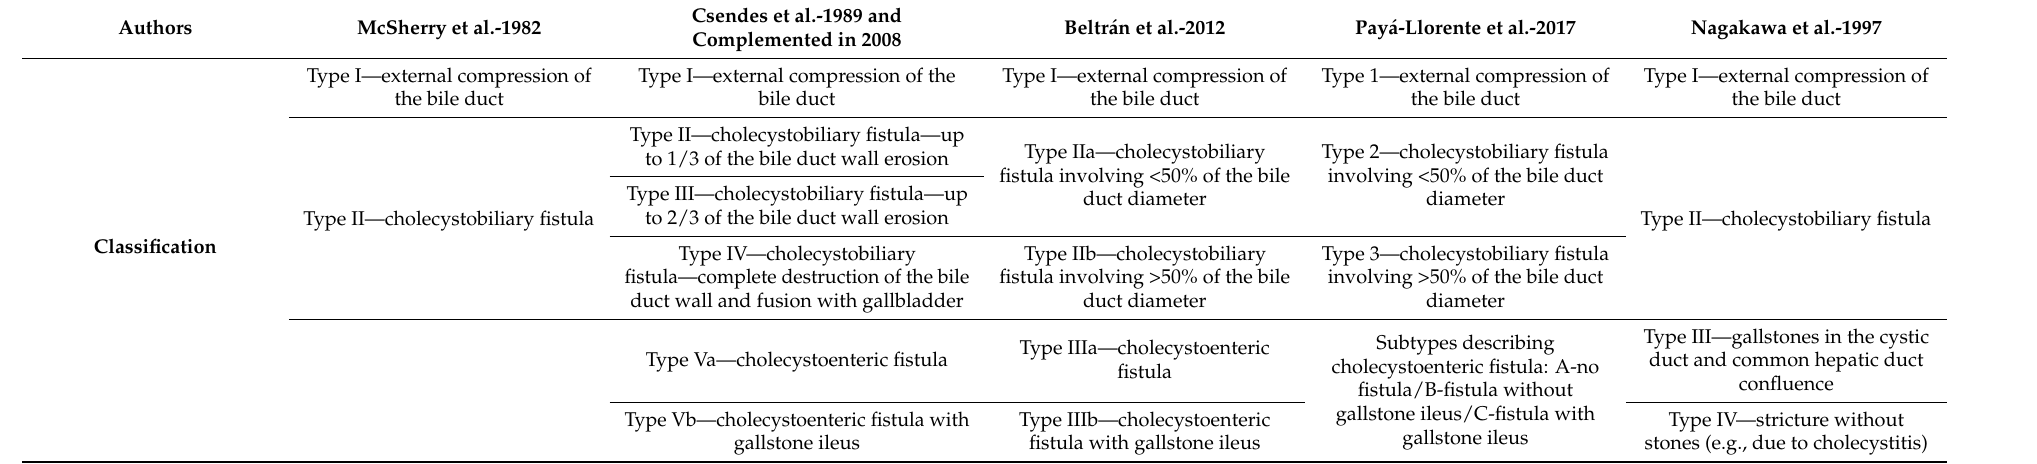
Table 1. Classifications of Mirizzi